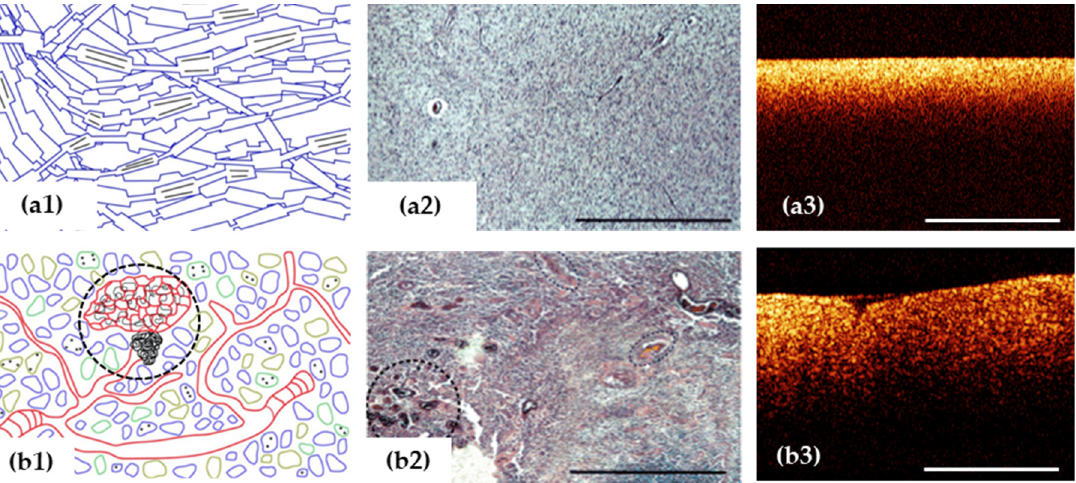
Figure 3. OCT signal ( a3 , b3 ) is formed by close-packed myelin fibers in white matter ( a1 – a3 ) and by a variety of cells, vascular proliferation and areas of necrosis (black dotted area) in glioblastoma demonstrated on histological images using hematoxylin and eosin staining ( b1 – b3 ). Scale bar is 1 mm in all images.